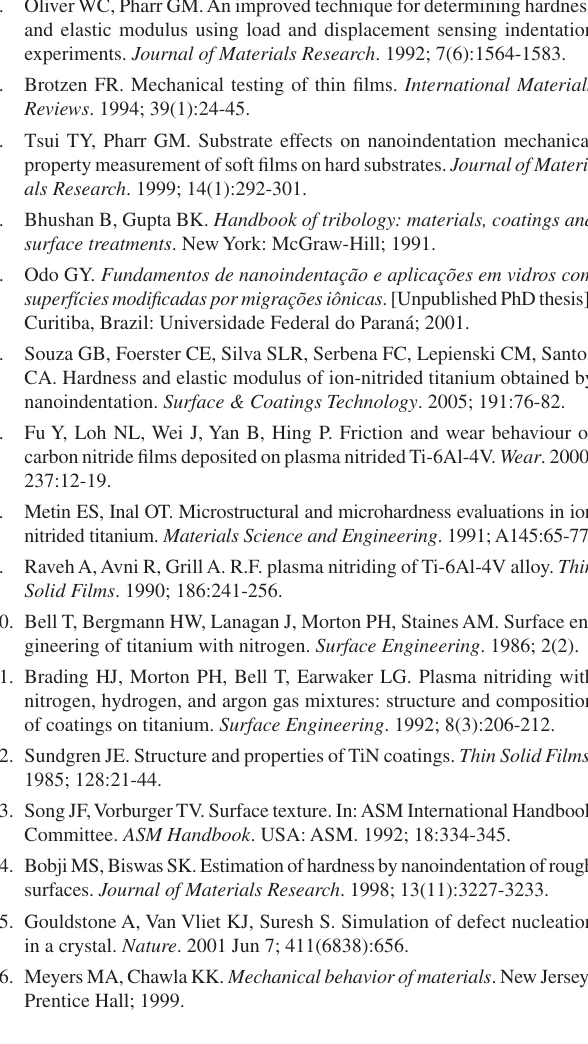
to higher values, reaching in some working conditions 23 GPa. In the same way elastic modulus changed from 136 GPa to 300 GPa. These corrected values are in agreement with the literature